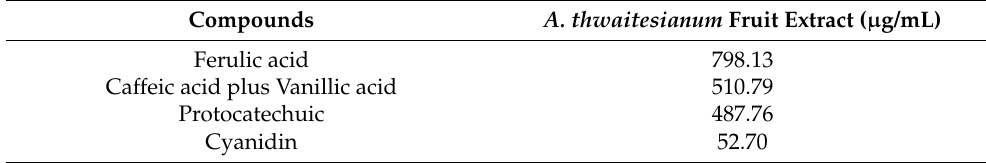
Table 1. The active compounds contained in the A. thwaitesianum fruit extract quantified by HPLC analysis.